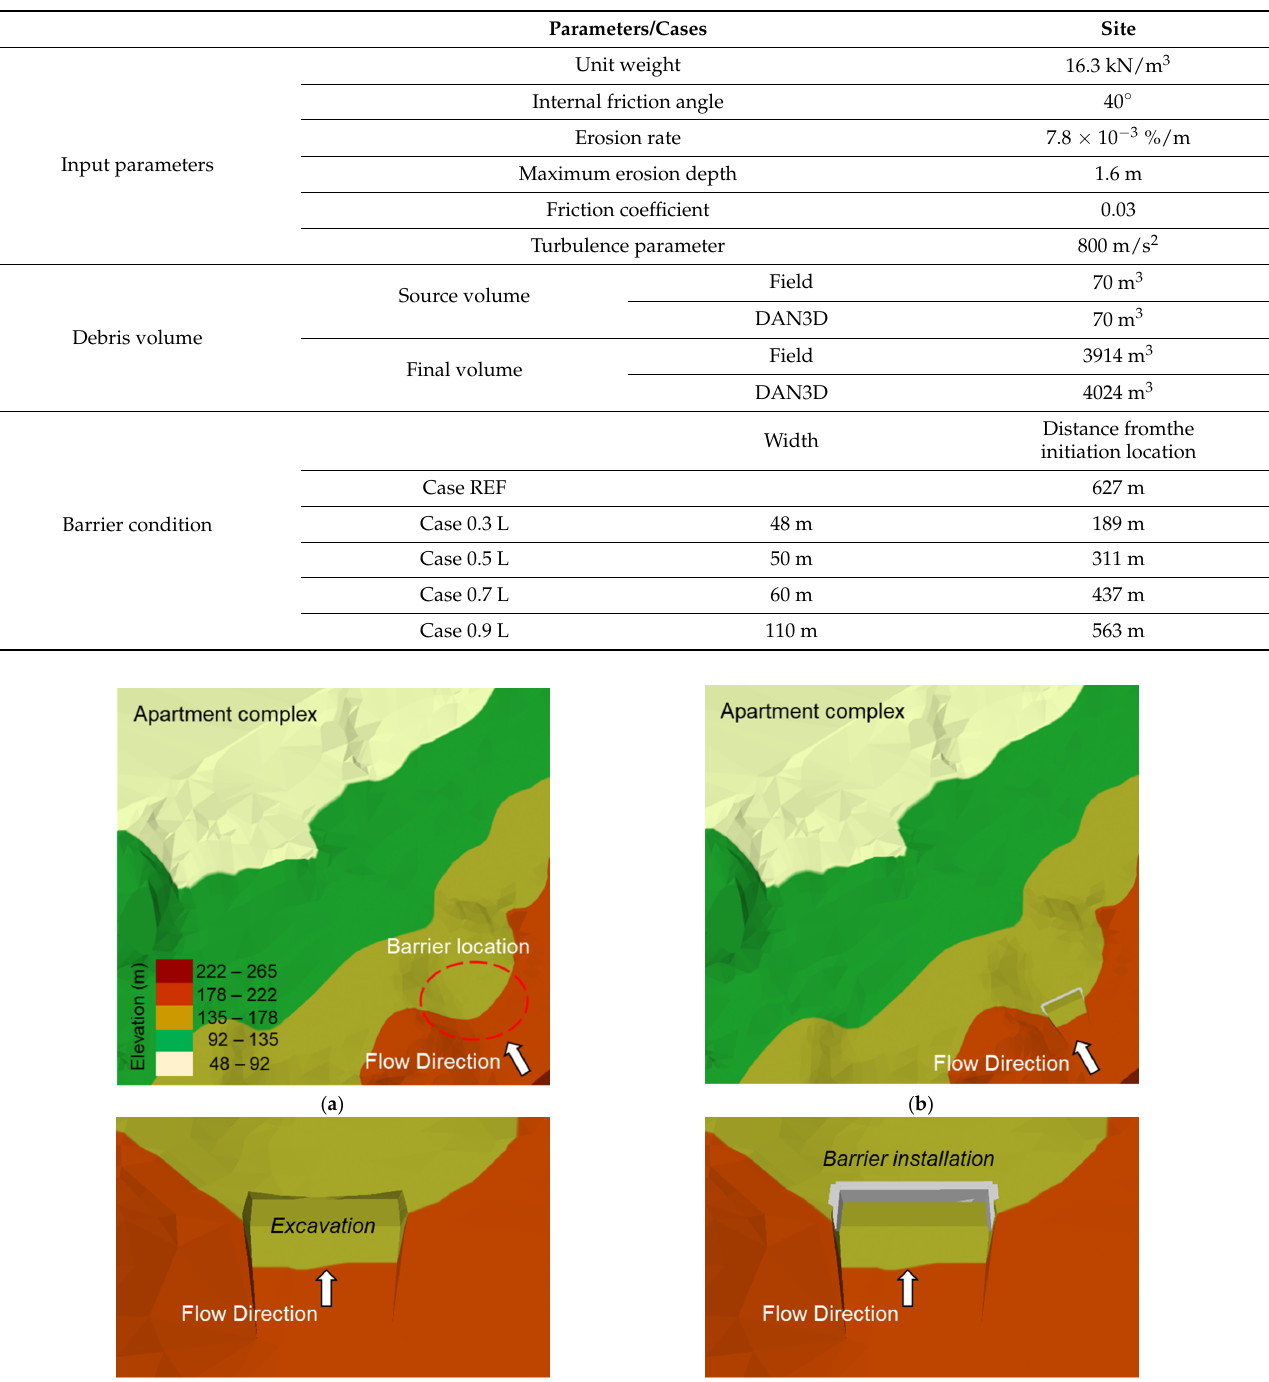
Table 1. Modeling conditions and properties of the debris-flow event and barriers.